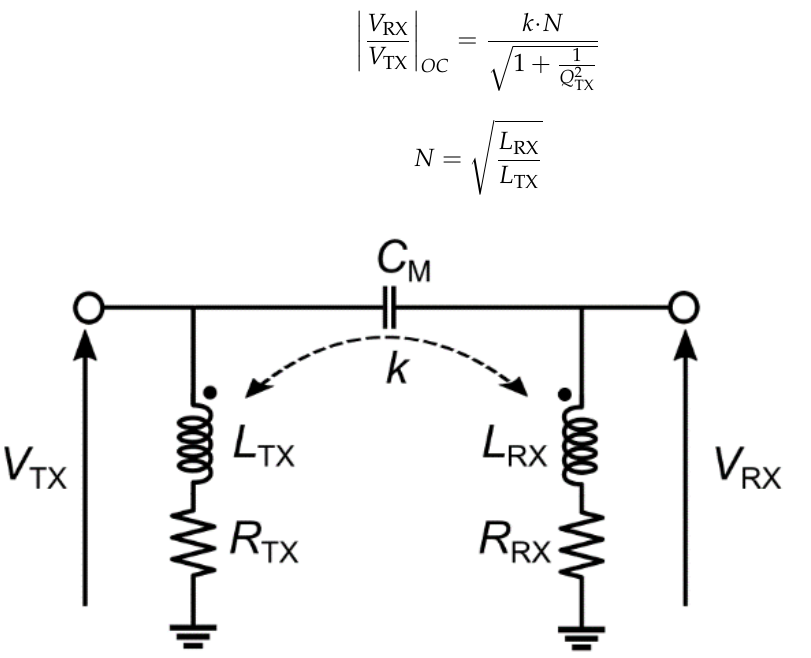
Figure 8. Simplified model of the isolated channel for TRX evaluation. Figure 9. Micro-antenna shape optimization.